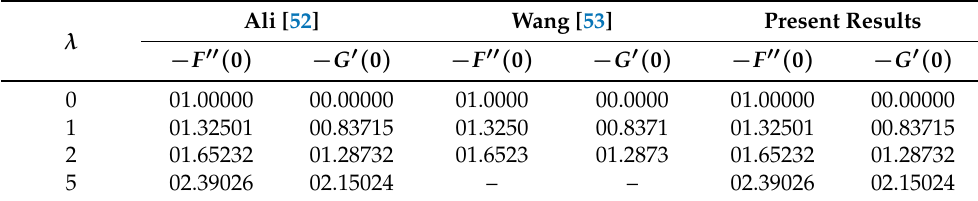
Table 2. Assessment of − F (cid:48)(cid:48) ( 0 ) and − G (cid:48) ( 0 ) for different values of λ when ζ = 1 and other parameters are fixed at zero.